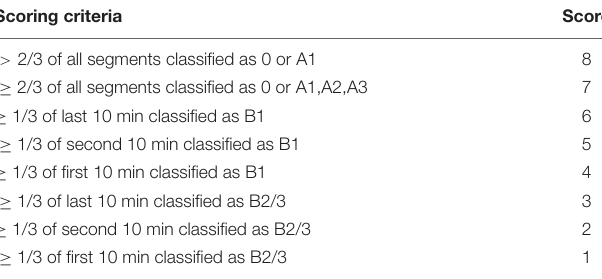
TABLE 1 | Scoring criteria of the arousal stability index. Scoring